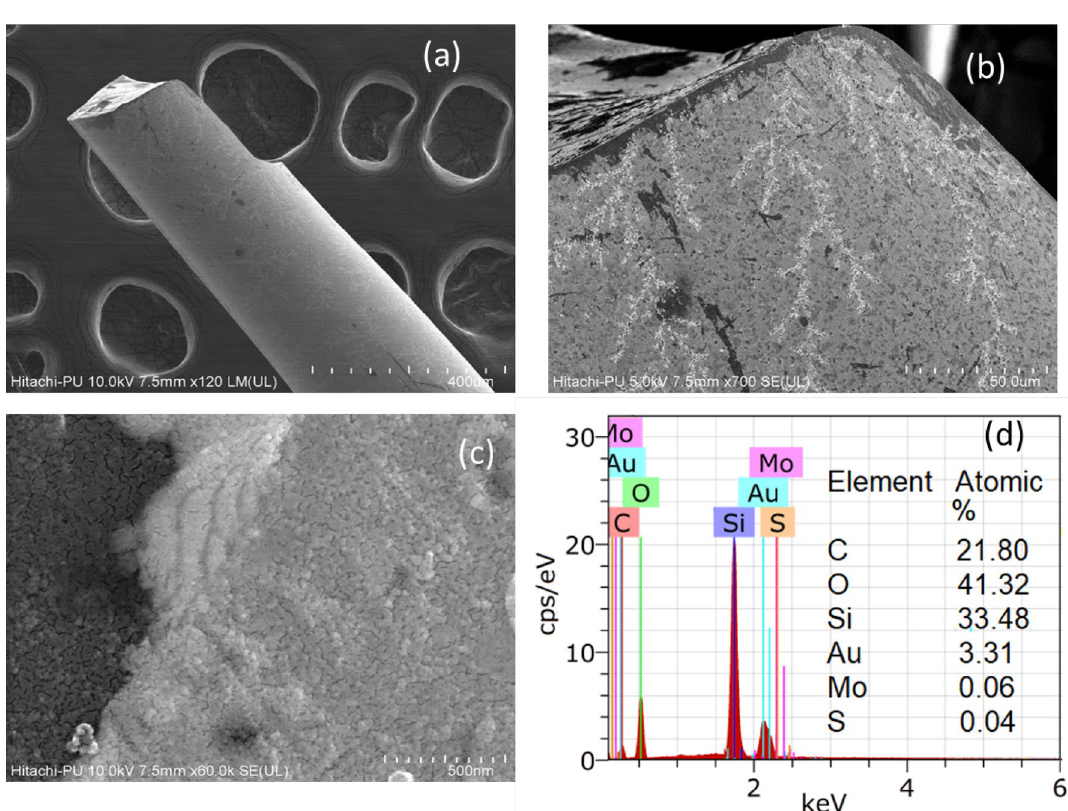
Figure 5. ( a ): FESEM image of a gold coated optical fiber; ( b , c ): FESEM images of L-Cysteine/MoS 2 deposited gold layered optical fiber; ( d ): EDX based elemental ratio analysis of L-Cysteine/MoS 2 deposited gold layered optical